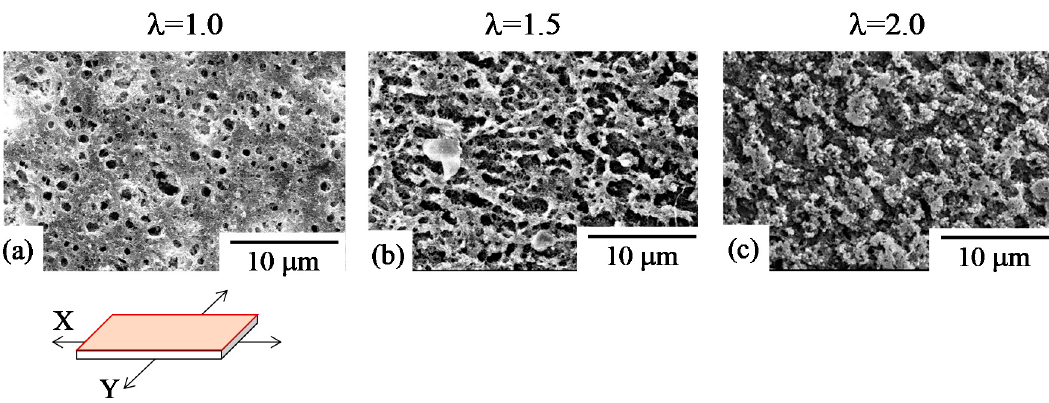
Figure 7. SEM micrographs of the surface of 70/30 PC/PMMA obtained by simultaneous biaxial stretching at various draw ratios λ . ( a ) λ = 1.0; ( b ) λ = 1.5; ( c ) λ = 2.0.